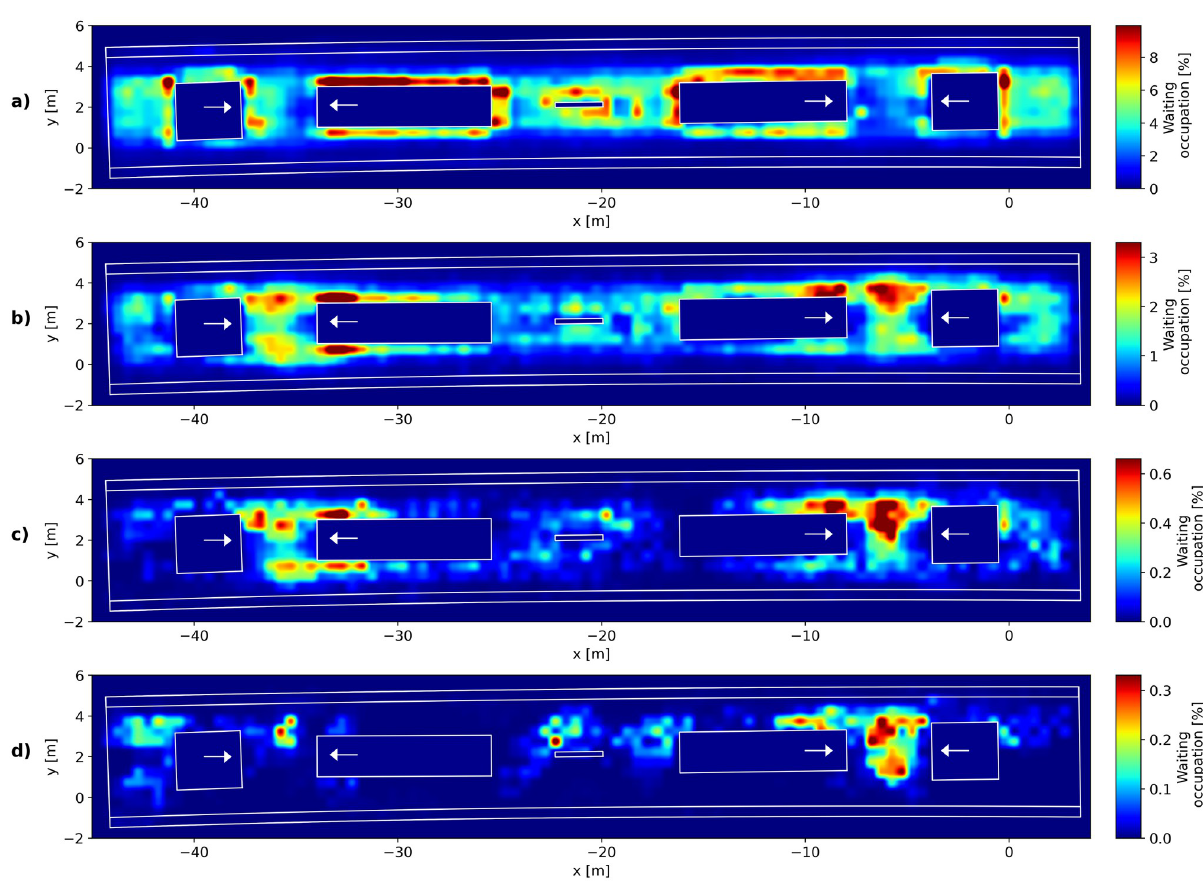
Fig 7. Waiting places of social groups and individuals. (a) individuals (b) groups with 2-3 members (c) groups with 4-5 members (d) groups with 6 or more members. Coloured areas indicate the occupation by waiting passengers as percentage of the total observation time.